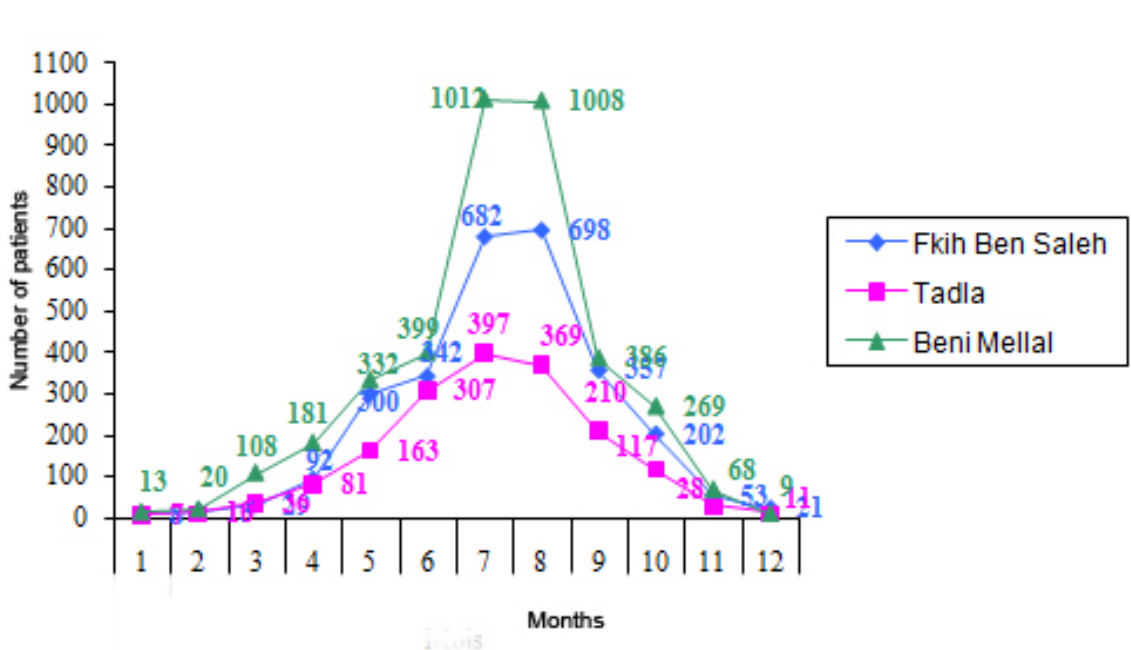
Figure 2. Distribution of scorpion stings cases by months in different health